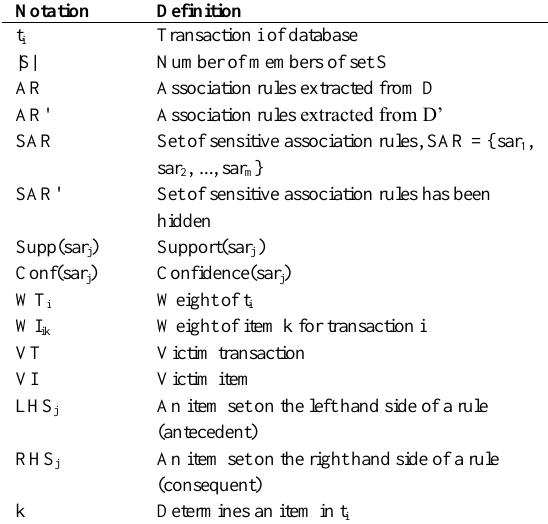
Table 1. Notations and